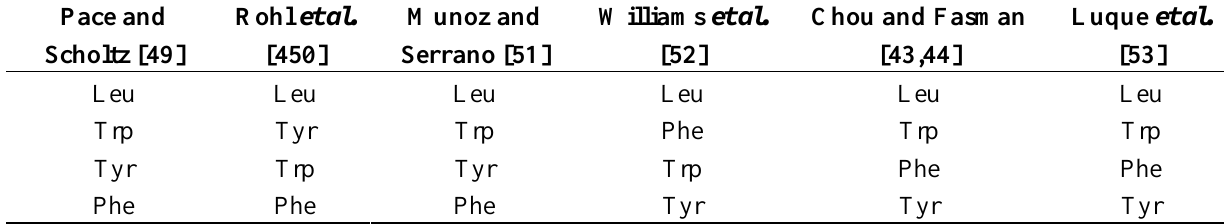
Table 9. α-helix propensities of Tyr, Trp, Phe and